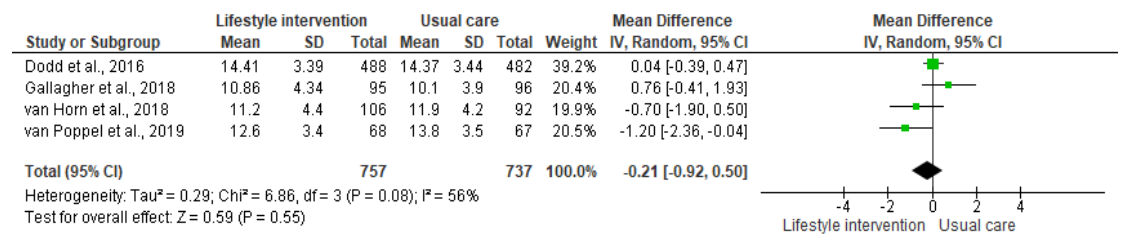
Figure 2. Effect of the lifestyle interventions in pregnant women with excessive body weight on neonatal adiposity [38–41]. SD = standard deviation; CI = confidence interval; Tau 2 = Tau-squared test; Chi 2 = Chi-squared test; Df = difference; P = p value; I 2 = heterogeneity; Z = Z test.